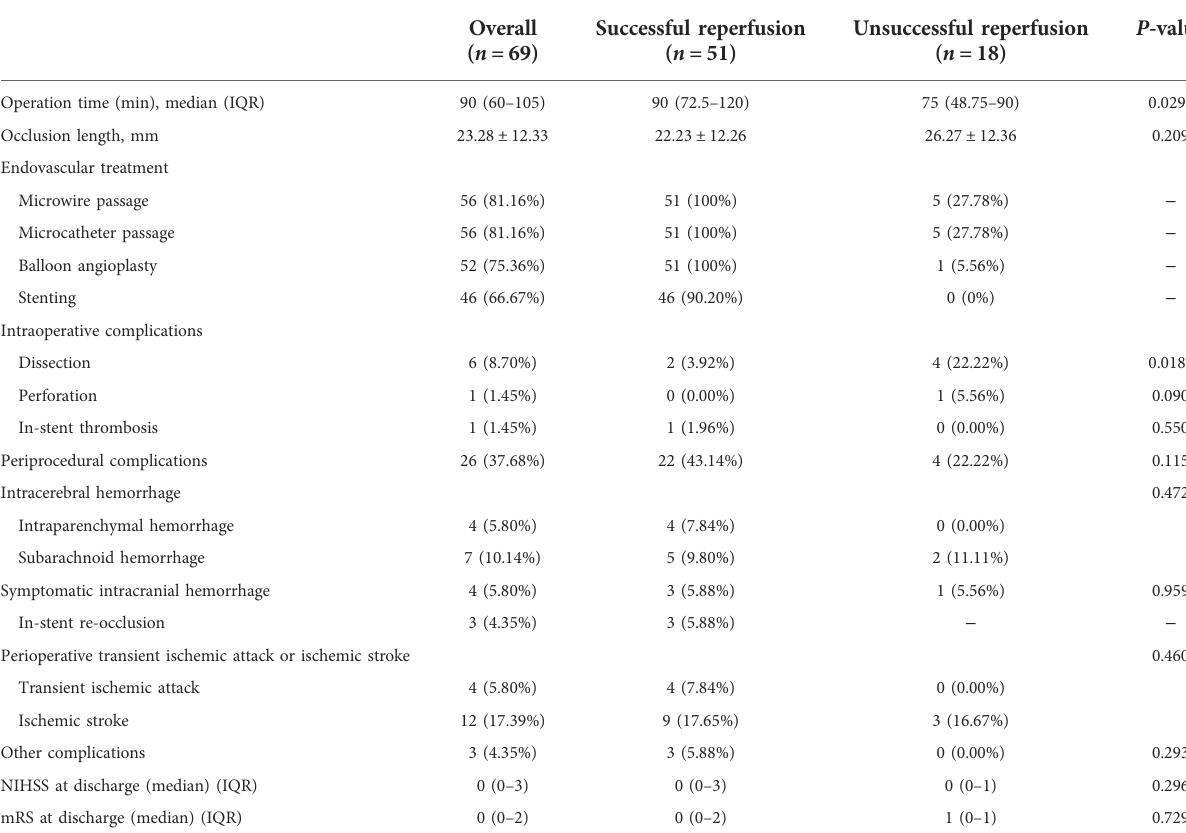
TABLE 2 Perioperative